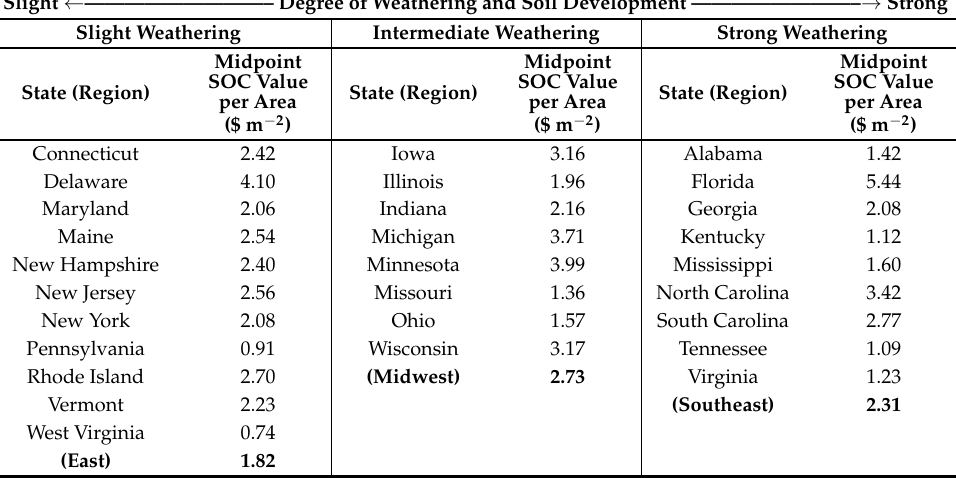
Table 15. Integration of biophysical accounts (science-based) and administrative accounts (boundary- based). Degree of soil development and area-normalized midpoint values of soil organic carbon (SOC) storage in the upper 2 m depth within the contiguous United States (U.S.), based on midpoint SOC numbers from Guo et al., 2006 [39] and a social cost of carbon (SC-CO 2 ) of $42 (USD) per metric ton of CO 2 [51]. Slight ← —————————– Degree of Weathering and Soil Development ————————– →